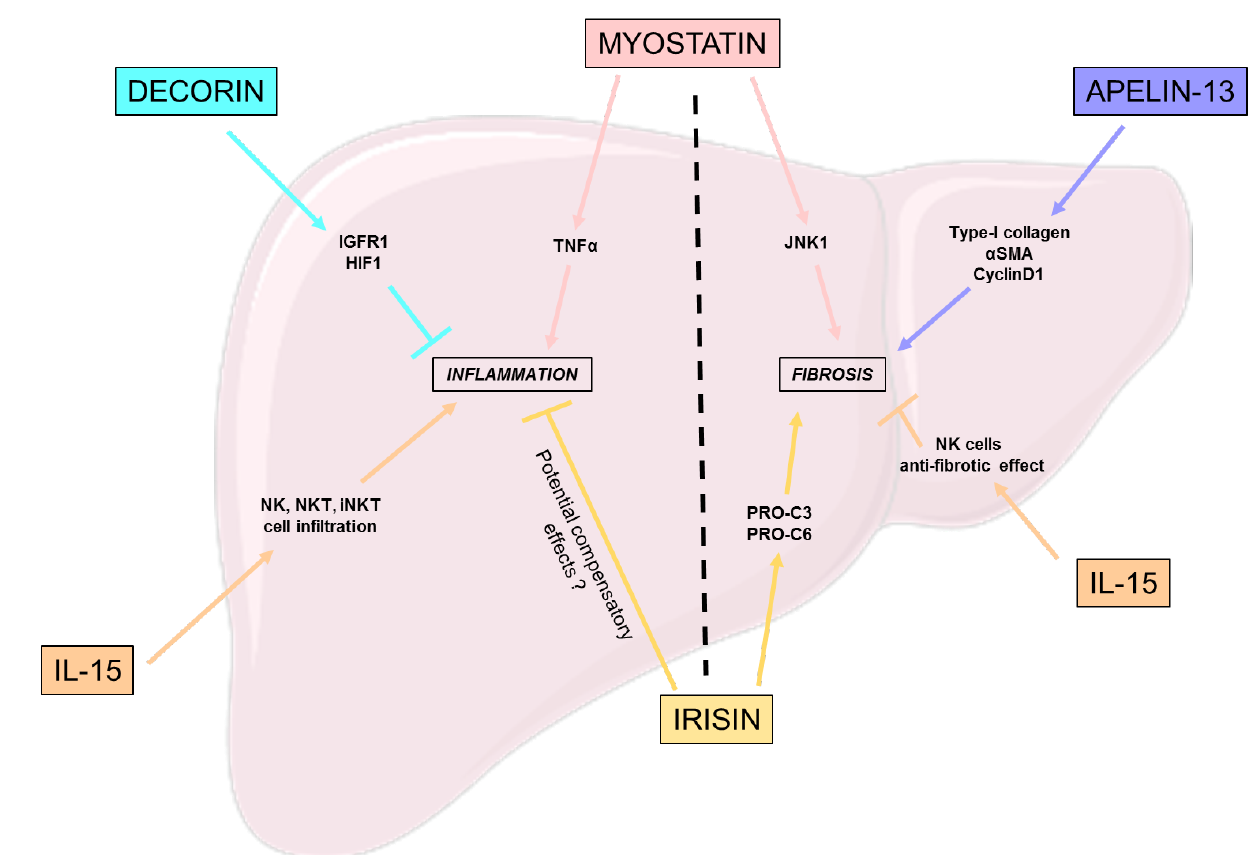
Figure 3. Effects of myokines on NASH hallmarks. This figure represents the beneficial, but also the deleterious effects of different myokines on the different hallmarks of NASH: inflammation and fibrosis. HIF-1: Hypoxia inducible factor 1; IGFRIR: Insulin growth factor I receptor; IL-15: Interleukine 15; JNK-1: c-Jun N -terminal kinase 1; NK: Natural killer; α-SMA: Alpha-smooth muscle actin; TNF: Tumor necrosis factor.